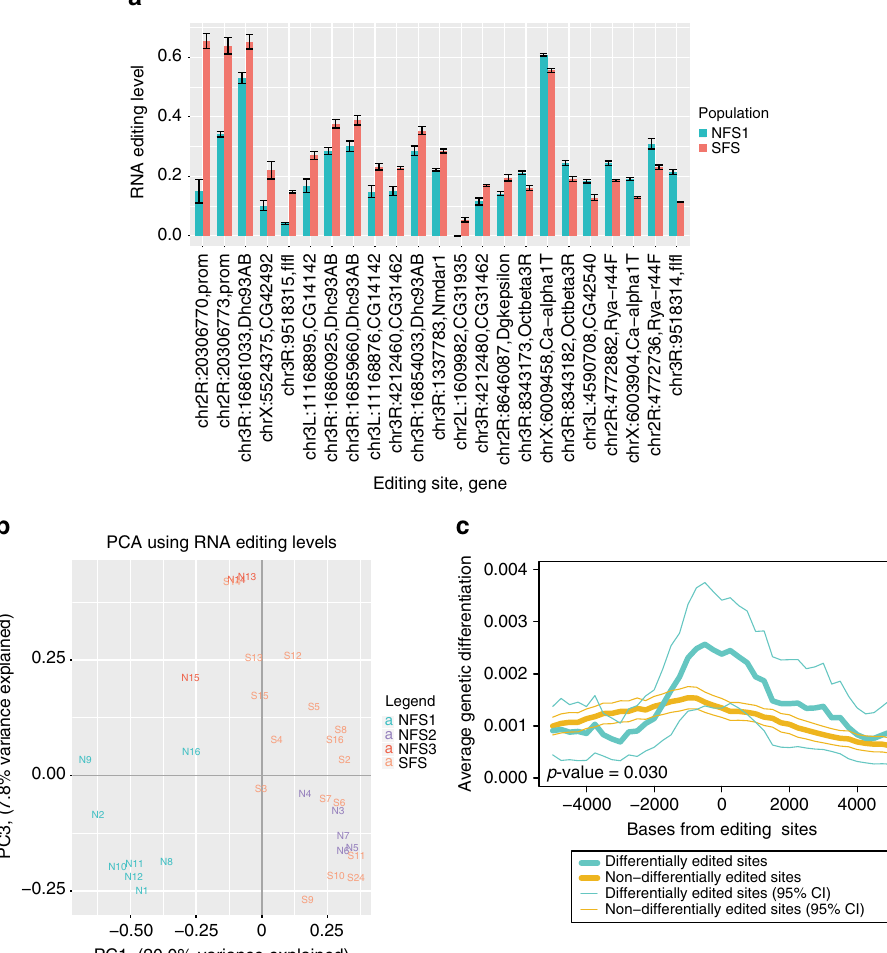
Fig. 3 RNA editing differences between NFS1 and SFS populations re fl ect genetic differences. a Barplot showing the average editing levels of sites with signi fi cantly different RNA editing levels between NFS1 (turquoise) and SFS (red) fl ies, from mmPCR-seq ( t -test, FDR-adjusted p -value < 0.05, editing level difference ≥ 5%). Error bars represent standard error of the mean. The number of fl y lines represented for each site per population ranges from 4 to 8 for NFS1 and 11 to 16 for SFS; Supplementary Data 6. b PCA plot using mmPCR-seq editing level measurements from all 32 Evolution Canyon fl y lines, with average editing levels from two biological replicates represented per line. The sub-populations are labeled as follows: NFS1 (turquoise), NFS2 (purple), NFS3 (red), SFS (orange). PC2, which represented 16.1% of the variance explained, was excluded from the plot because it correlated with when the samples were sequenced (Supplementary Fig. 7b). c Plot showing signi fi cant enrichment of differentiated SNPs near signi fi cantly differentially edited sites (turquoise) compared to non-differentially edited sites (gold) between the NFS1 and SFS fl y populations, along with the 95% con fi dence interval ( p -value = 0.030, one-sided KS